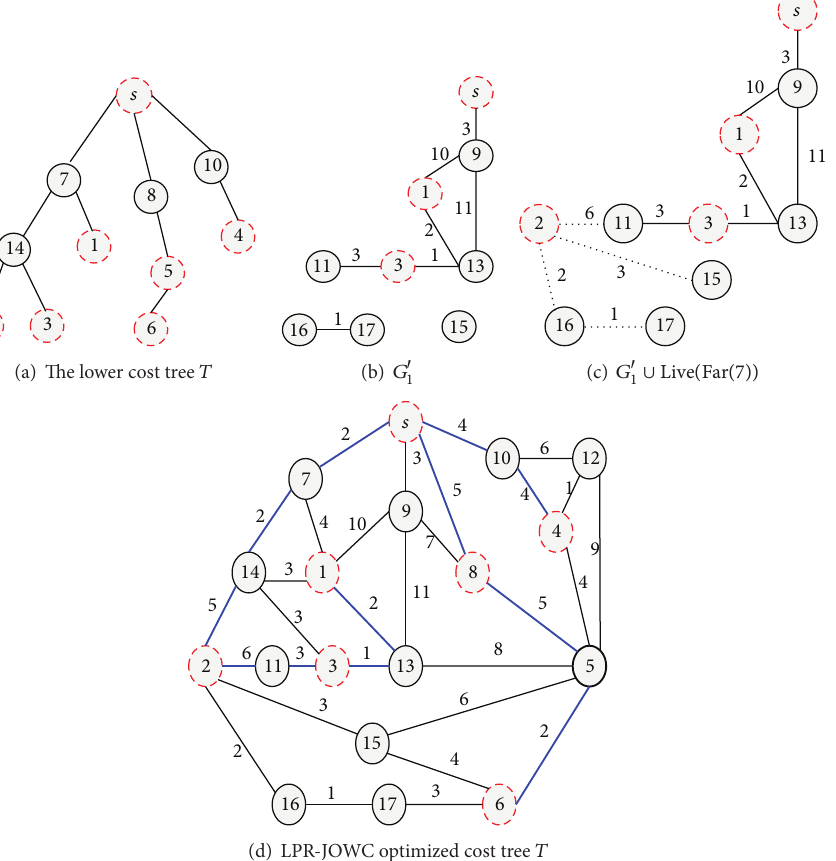
Figure 3: An example of LPR-JOWC algorithm execution.